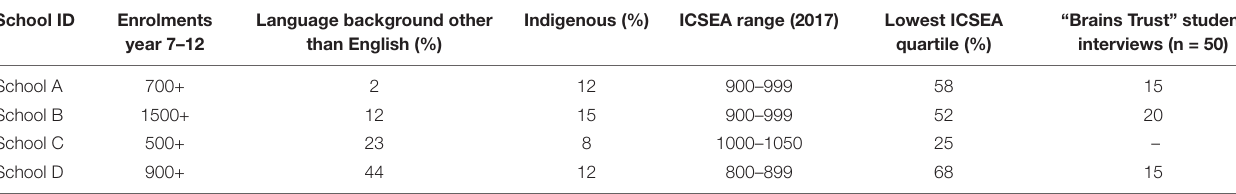
TABLE 1 | School demographics and distribution of student